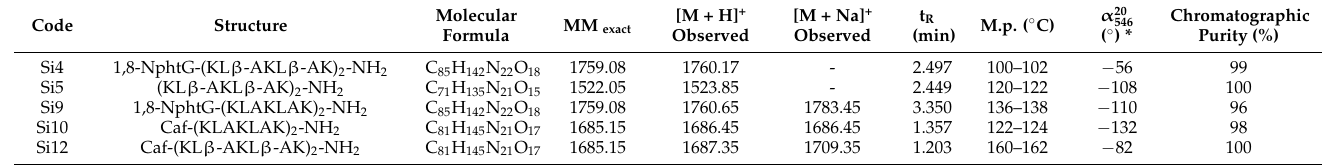
Table 1. Structure and analytical data for newly synthesized compounds.